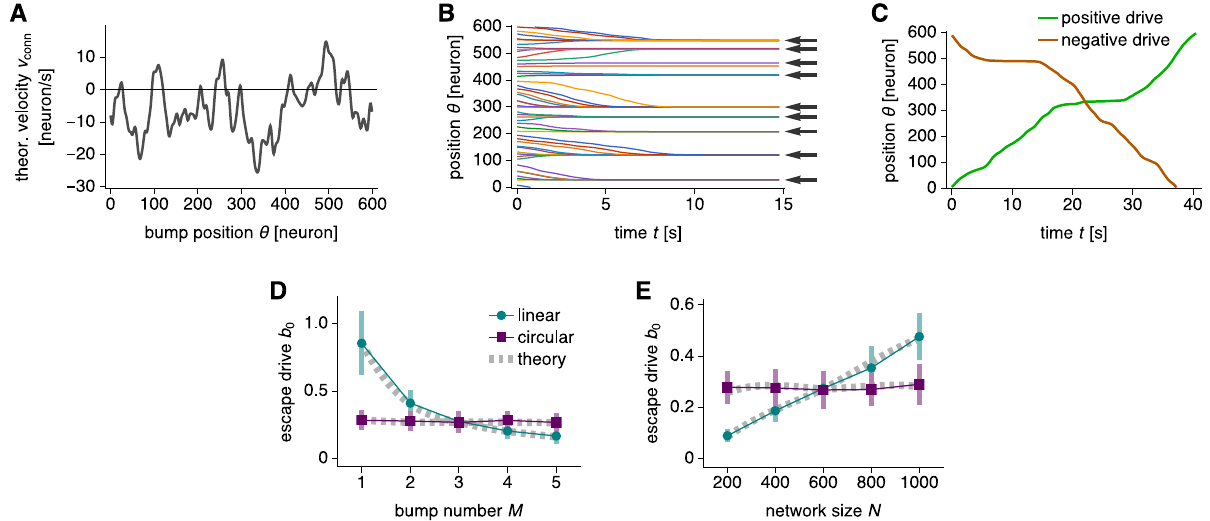
Fig 7. Bump trapping due to connectivity noise at low drive. ( A – C )Networks with 600 neurons, 1 bump, and the same realization of connectivity noise of magnitude 0.002. ( A ) Theoretical values for drift velocity as a function of bump position using Eq 24. ( B ) Bumps drift towards trapped positions over time. The drive is b = 0. Arrows indicate predictions from v conn ( θ ) crossing 0 with negative slope in A . Lines indicate simulations with different starting positions. ( C ) Bump trajectories with smallest positive and negative drive required to travel through the entire network. Respectively, b = 0.75 and b = − 0.52. The larger of the two in magnitude is the escape drive b 0 = 0.75. Note that positions with low bump speed exhibit large velocities in the opposite direction in A . ( D and E ) Networks with multiple realizations of connectivity noise of magnitude 0.002. ( D ) Escape drive decreases with bump number under linear mapping and remains largely constant under circular mapping. Networks with 600 neurons. ( E ) Escape drive increases with network size under linear mapping and remains largely constant under circular mapping. Networks with 3 bumps. Points indicate simulation means over 48 realizations and bars indicate standard deviations. Dotted gray lines indicate Eq 26 averaged over 96 realizations.